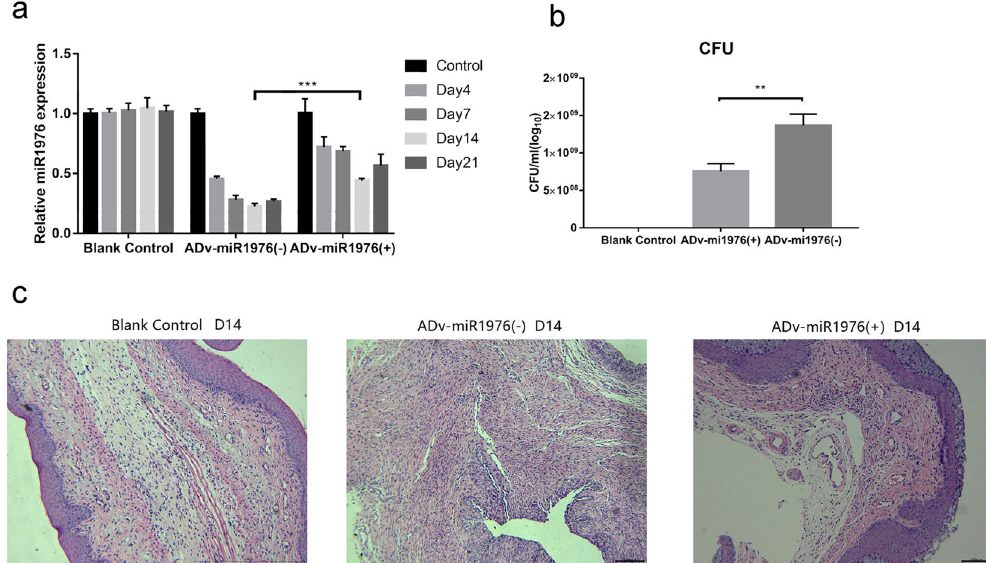
Figure 3. MiR-1976 overexpression reversed E. coli -induced vaginal infection in mice. ( a ) Administration of the miR-1976 overexpression vector restored the miR1976 expression suppressed by E. coli infection in the vaginal tissues of mice, as measured by qRT-PCR analysis; ( b ) The total number of vaginal microbes was significantly reduced after administration of the miR1976 adenoviral vector. ( c ) Histological analysis showed that abnormal pathological changes caused by E. coli can be reversed by miR1976 overexpression. * P < 0.05, ** P < 0.01, compared with the control group; ** P < 0.01, compared with the E. coli infection